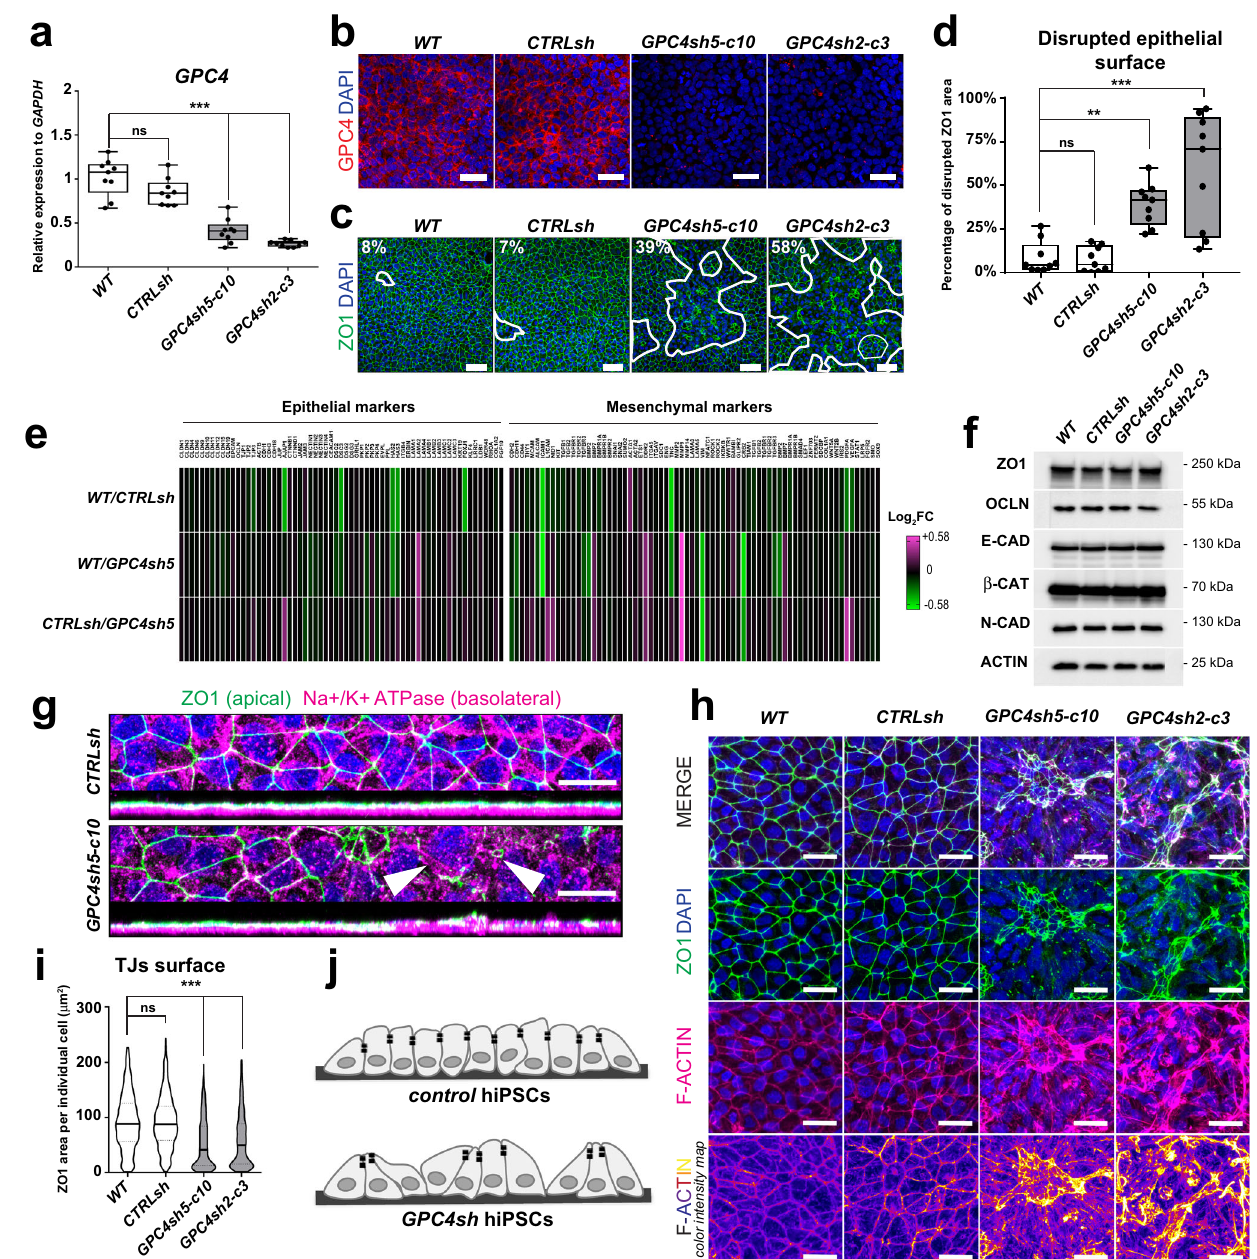
Fig. 1 | GPC4 downregulationin hiPSC affects epithelialintegrity byaltering TJ distribution. a RT-qPCR analyses of GPC4 transcript levels in WT, CTRLsh, GPC4sh5-c10 and GPC4sh2-c3 029 hiPSCs. Box plots represent the median with interquartile range, the whiskers indicate min and max values, n =9. b Immuno fl uorescence analysis of GPC4 (red) and DAPI positive nuclei (blue) in WT, CTRLsh, GPC4sh5-c10 and GPC4sh2-c3 hiPSCs, n =3. Scale bar: 50 μ m. c Immuno fl uorescence analysis of ZO1 (green) in WT, CTRLsh, GPC4sh5-c10 and GPC4sh2-c3 hiPSCs. Numbers indicate the percentage of disrupted areas. White outlineshighlightzonesofdisturbed TJs, n =9.Scalebar:50 μ m. d TheextentofTJ disruptionwasquanti fi edfromstainingshownin c .Boxplotsrepresentthemedian withinterquartilerange,thewhiskersindicateminandmaxvalues, n =9. e RNA-seq analyses of transcript levels of epithelial and mesenchymal genes in WT, CTRLsh, GPC4sh5-c10hiPSCs.DataarerepresentedasaheatmapofLog 2 FC, n =3. f Western- blot analysisofZO1, OCLN, E-CAD, β -CATand N-CADinWT,CTRLsh, GPC4sh5-c10 and GPC4sh2-c3 hiPSC total protein extracts. ACTIN protein levels were used as